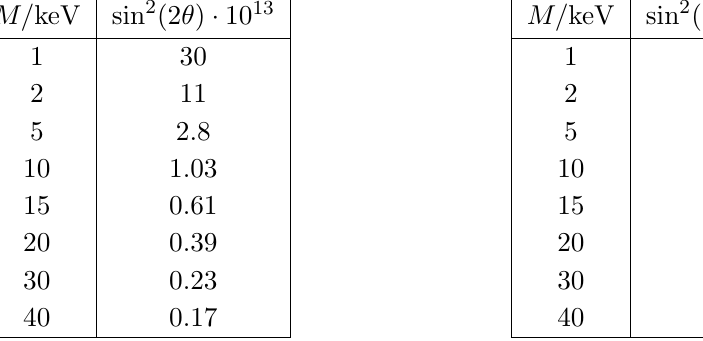
Table 1 . Mixing angle that leads to the complete relic DM abundance for various masses, with total initial asymmetry n L =s = 2 : 5 (cid:1) 10 (cid:0) 3 . Left: asymmetry only in the muon (cid:13)avor, right: all three asymmetries initially equal, n L =s = n L = 3 s (cid:11)